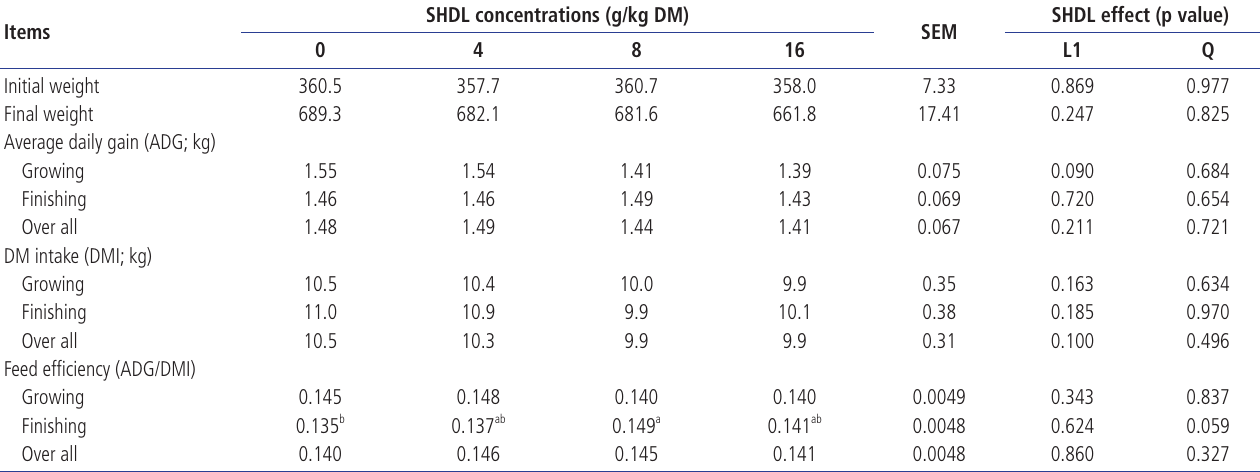
Table 5. Effects of sodium hydroxide dehydrated lignin (SHDL) on the growth performance of feedlot cattle fed barley grain and barley silage based total mixed rations (n = 15) SHDL concentrations (g/kg DM) Items